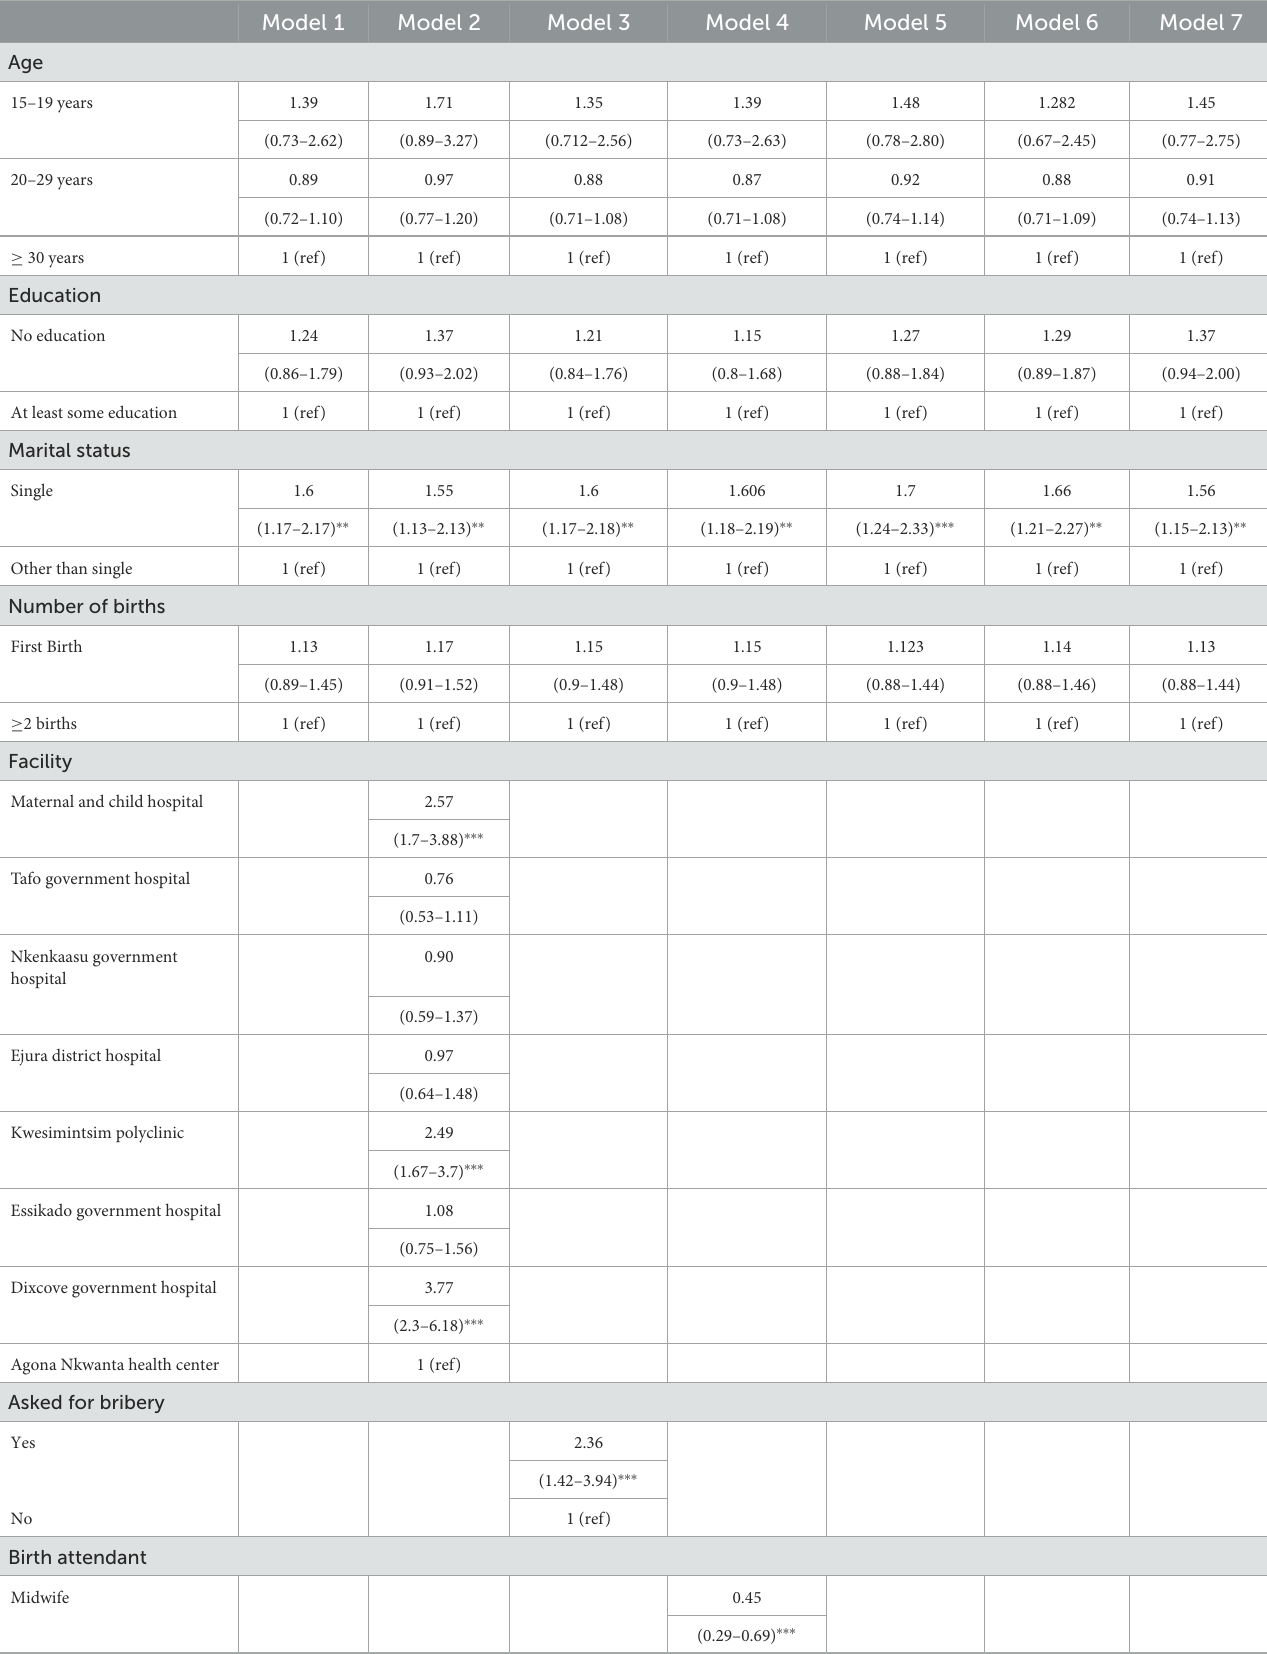
TABLE 3 Multivariable Logistic regression models of the factors associated with any form of obstetric